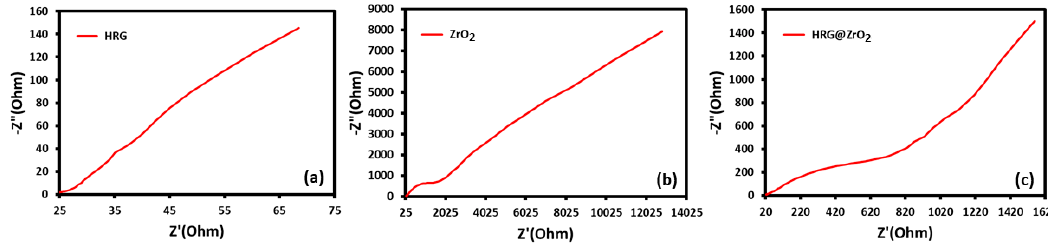
Figure 10. Electrochemical impedance spectroscopy plots of HRG, ZrO 2 and HRG@ZrO 2 . ( a ) HRG ( b ) ZrO 2 ( c ) HRG@ZrO 2